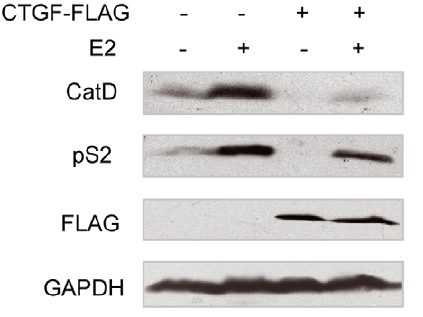
Figure 5. CTGF reduces estrogen-responsive protein expres- sion. MCF7 cells stably transfected with FLAG-tagged CTGF were treated with E2 or without E2. Conditioned media were blotted with antibodies to cathepsin D (CatD), pS2 and FLAG, and whole cell lysates were blotted with anti-GAPDH.